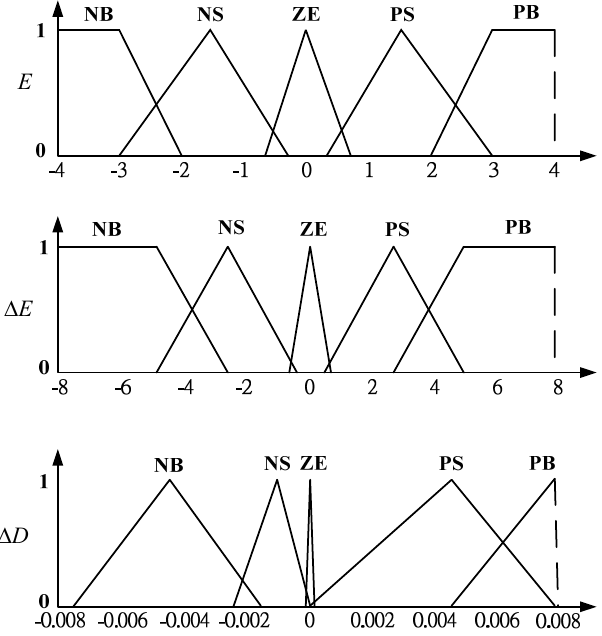
Figure 12. Membership functions for the input and output